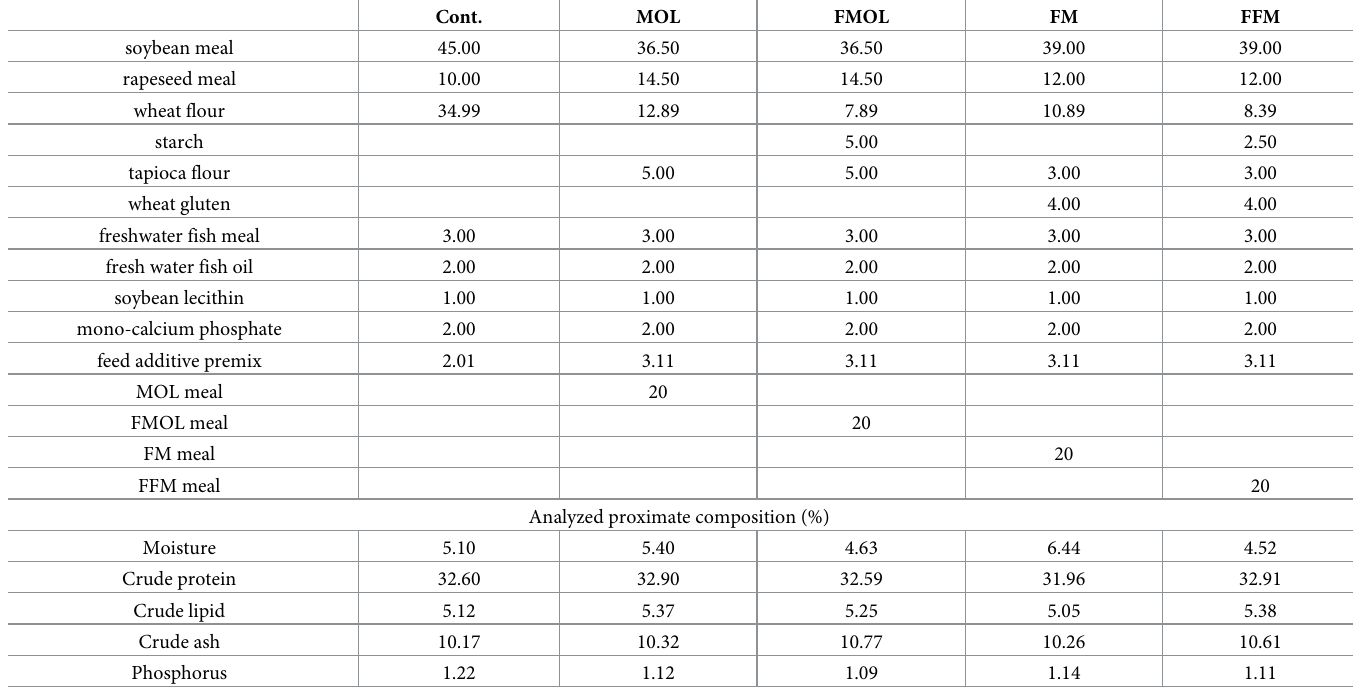
Table 1. Feed formulation and proximate composition of the five test feeds